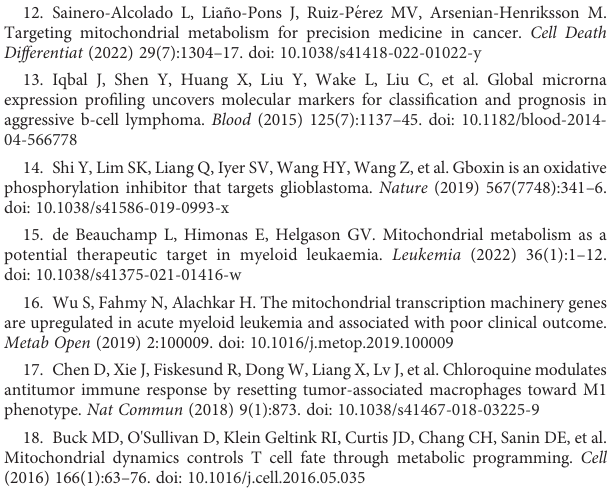
SUPPLEMENTARY FIGURE 9 Difference analysis between high- and low-risk groups. A, B . Expression of immune-related genes (A) and DNA repair genes (B) in the AML patients. C, D . Relationships between hub genes and immune-related genes (C) and DNA repairgenes (D) . E-G . Stacked histogram of the proportions of age (E) , gender (F) , OS event (G) . *P-value<0.05, **P-value<0.01,